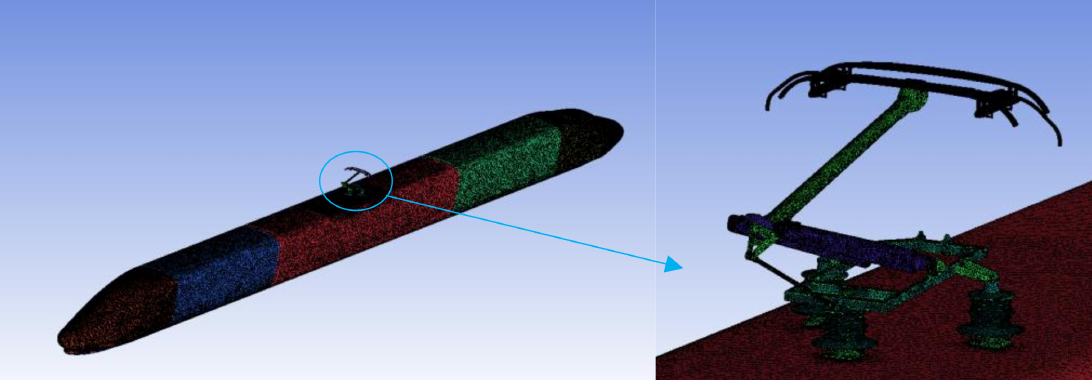
Figure 2. The geometric model of the tunnel and the aerodynamic model of the outflow field.